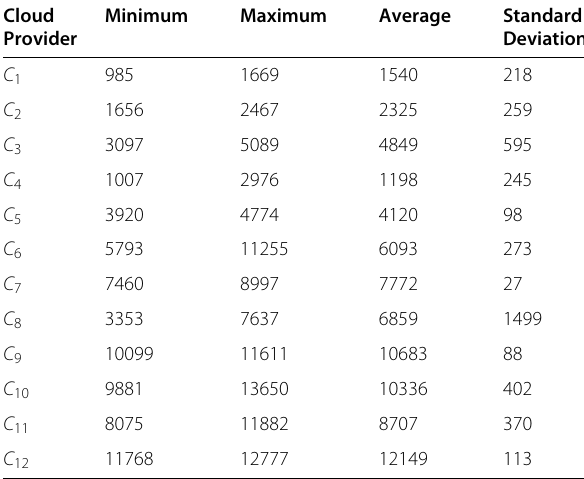
Table 4 Payoff distribution for individual cloud providers based on 10000 random